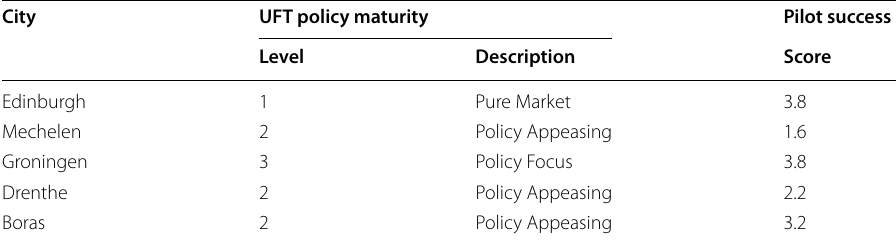
Table 4 Five case study cities, UFT policy maturity and pilot success